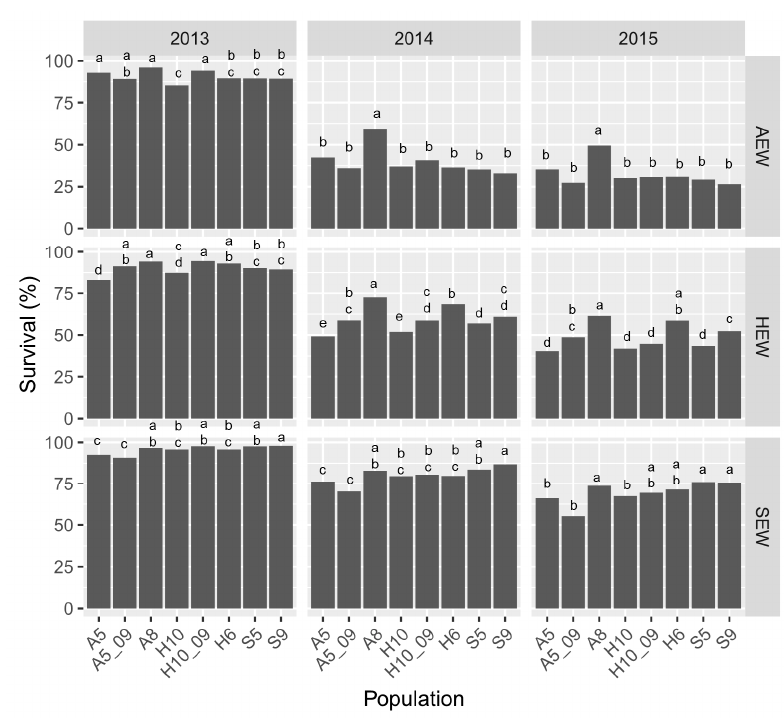
Figure 6. Survival rate of the different populations from 2013 to 2015 in the regions. Different letters indicate significant differences among populations. (Populations from the SEW region: S5 and S9; from HEW: H10, H10_09, and H6; from AEW: A5, A5_09, and A8. For the populations H10 and A5, seeds from 2009 were also available for raising seedlings and are named H10_09 and A5_09,